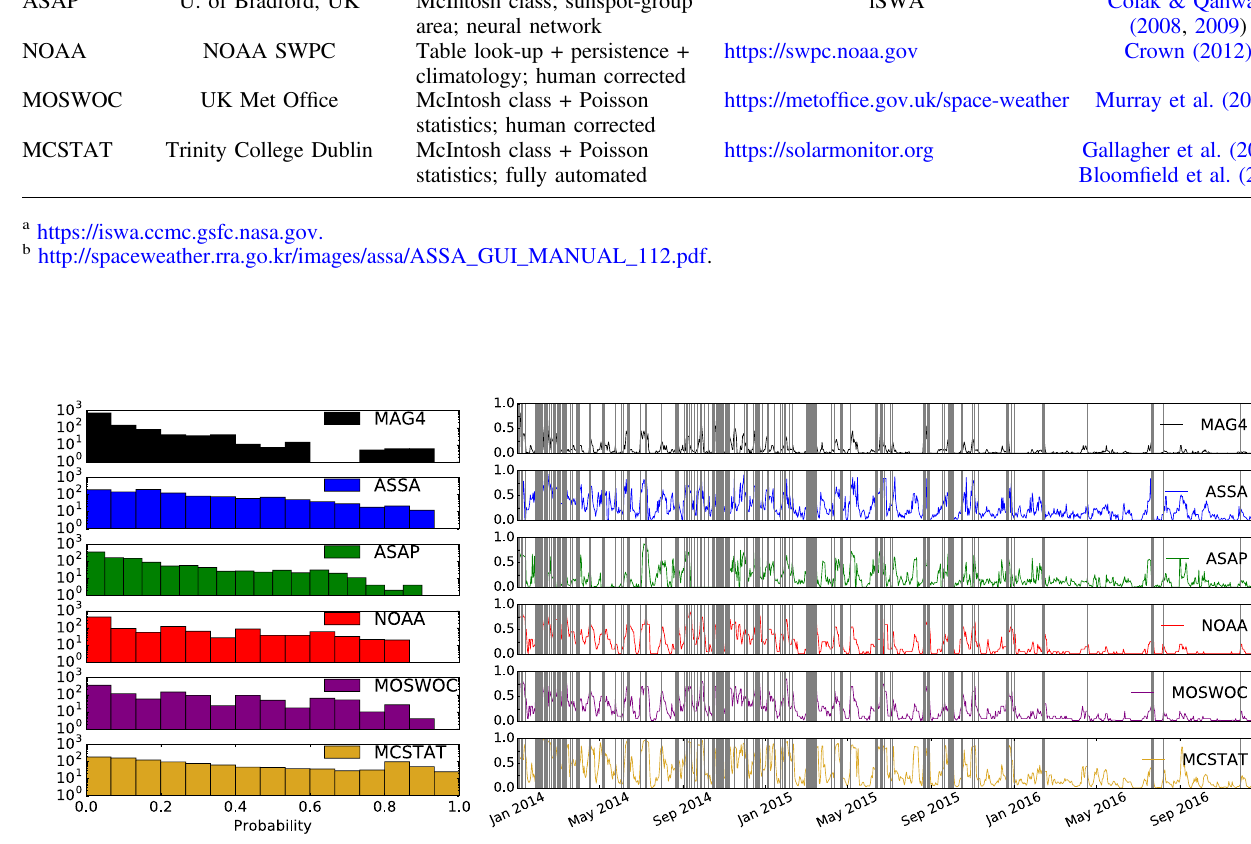
Fig. 2. Data sample. Probabilistic forecasts and events for M-class fl ares (histograms, left panels; time series, right panels). From the top, forecasting methods (color) are: MAG4 (black), ASSA (blue), ASAP (green), NOAA (red), MOSWOC (purple), and MCSTAT (gold). In the right panels, vertical grey lines signal positive events, i.e., days when at least one M-class fl are was